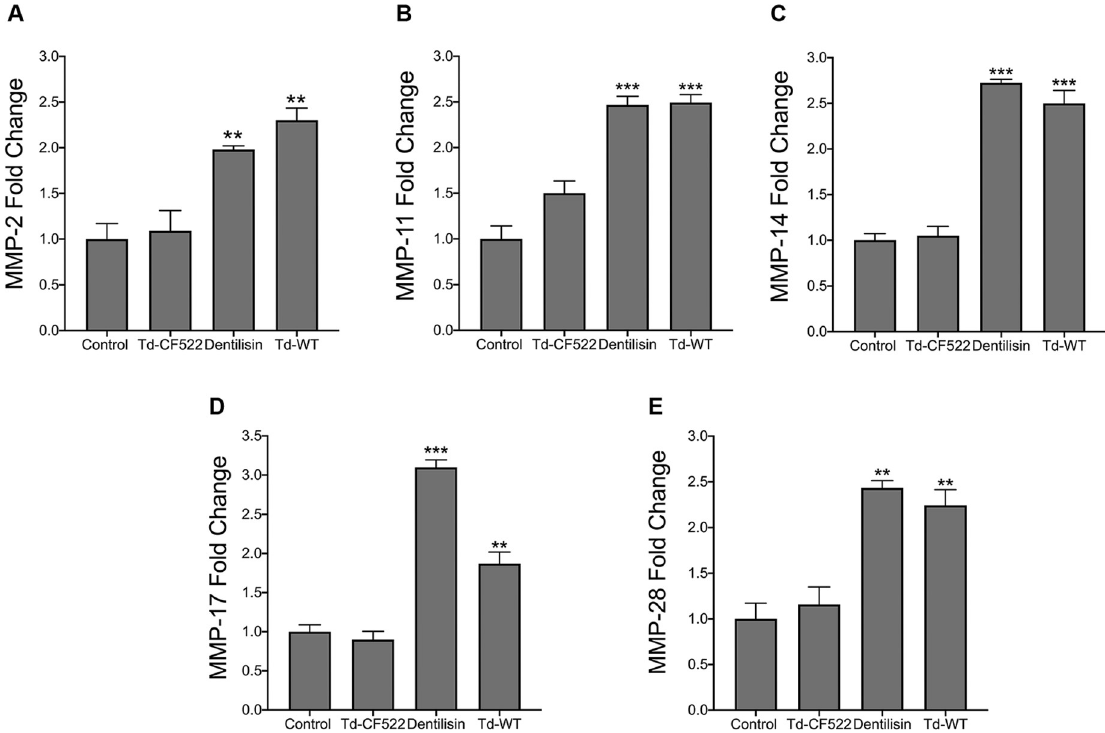
Fig 3. T . denticola s urface-expressed dentilisin mediates the upregulation of MMP 2, 11, 14, 17 and 28 mRNA levels in hPDL cells. (A-E) RT-qPCR for MMP-2 , MMP-11 , MMP-14 , MMP-17 and MMP-28 mRNA expression of healthy hPDL cells challenged with isogenic Td-CF522 bacteria, Td-WT bacteria and purified dentilisin. Cells were stimulated at an MOI of 50 and a final concentration of of 1 μ g/mL. Cells were challenged for 2-hours in alpha-MEM media supplemented with 10% FBS followed by a 22-hour incubation in alpha-MEM media with 10% FBS, 1% PenStrep and 1% Amphotericin B. The expression of each gene was normalized to that of GAPDH . Statistical significance was determined using a One-Way ANOVA followed by Tukey’s Post-Hoc multiple comparisons. Bars represent mean ± SEM (n = 4). �� p < .01 versus control. ��� p < .001 versus